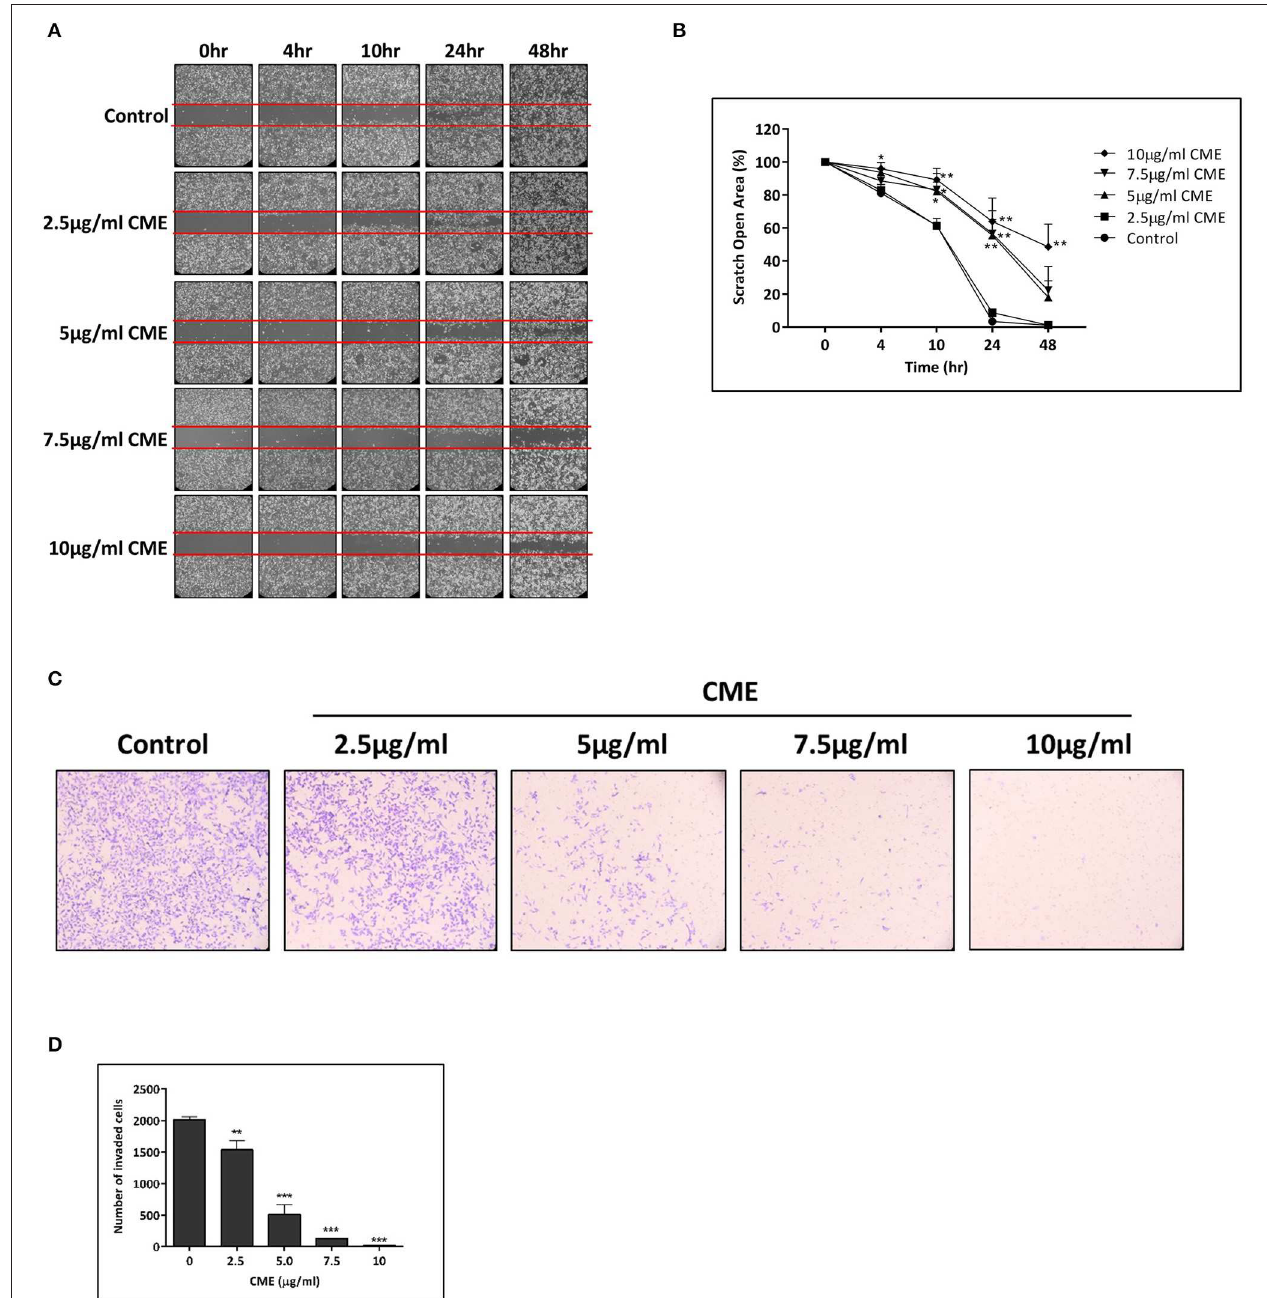
FIGURE 3 | CME inhibited cell migration and invasion in MDA-MB-231. MDA-MB-231 cells were treated with various concentrations of CME (2.5, 5, 7.5, and 10 µ g/ml) for the indicated durations. (A,B) Cell migration was assessed via wound-healing assay and quantified. (C,D) Cell invasion was assessed by the transwell invasion assay, and the number of invasive cells quantified. Data are presented as the means ± SD from three independent experiments. * P < 0.05, ** P < 0.01, and *** P < 0.001 vs. control.